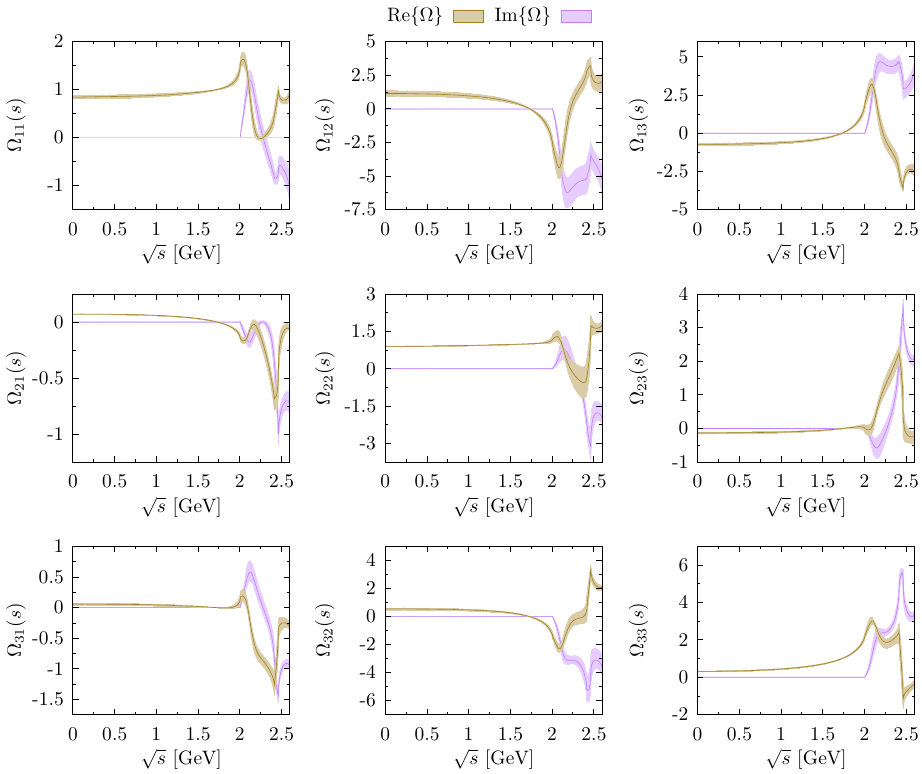
( ∞ ) = 0. Error bands have been obtained by Monte Carlo propa- δ (cid:22) (cid:21) D s ¯ K = I , ( m − M π ) 2 gating the uncertainties of the LECs quoted in Ref. D